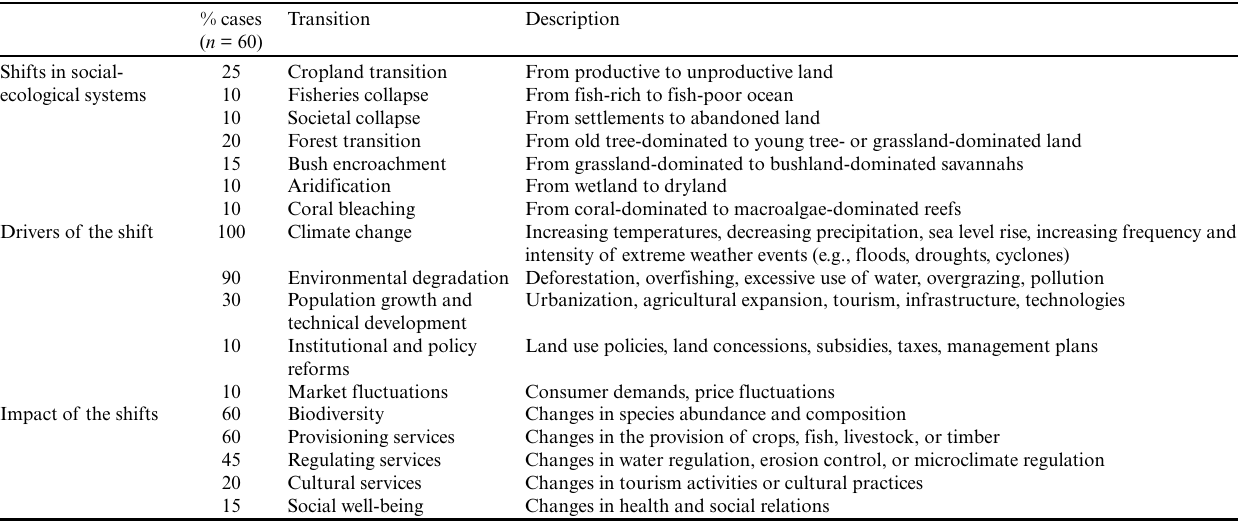
Table 1 . Summary of shifts in trajectories of social-ecological systems driven by climate change and other drivers, and their impact reported in the 60 case studies (see Appendix 1 for details on the individual case